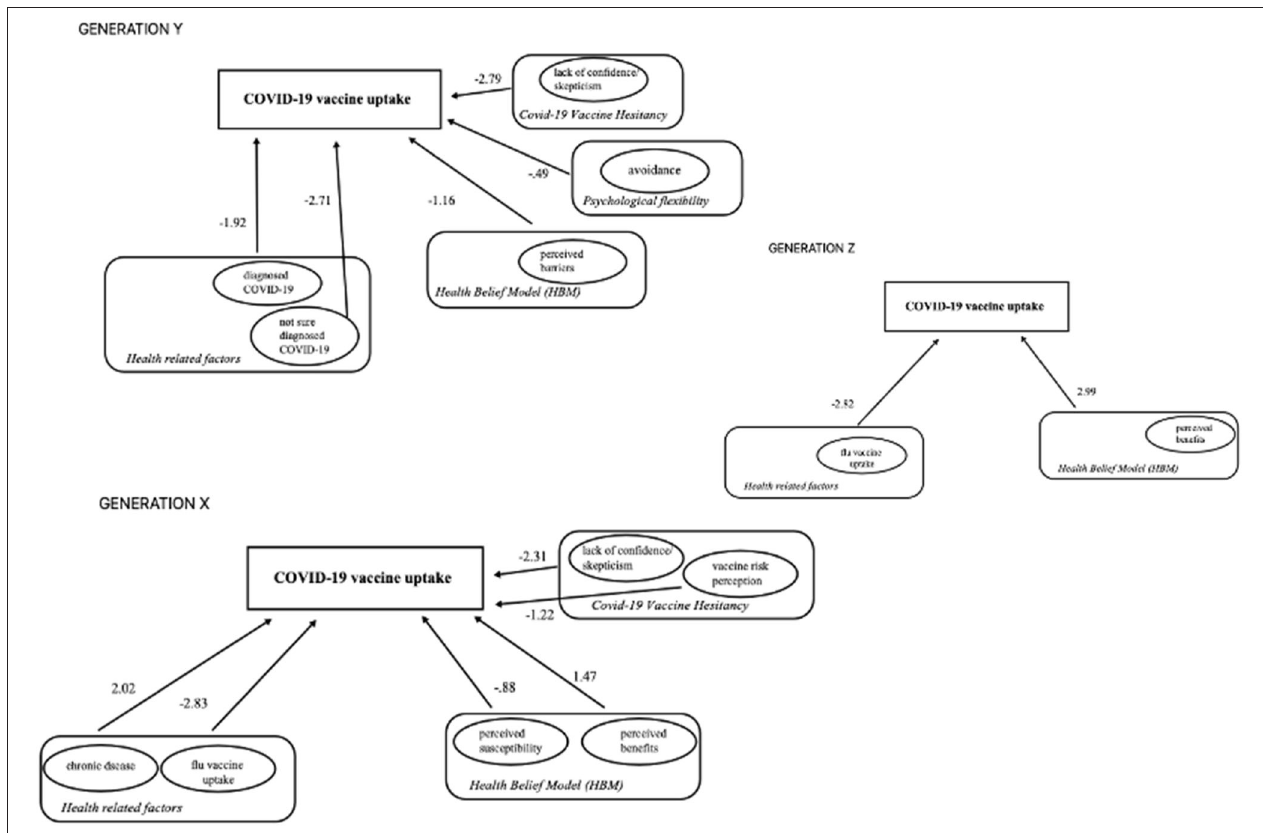
FIGURE 1 | Predictors of COVID-19 vaccine uptake in women of Gen X, Y, and Z. Values represent unstandardized beta (B) values from multivariate binary logistic regression